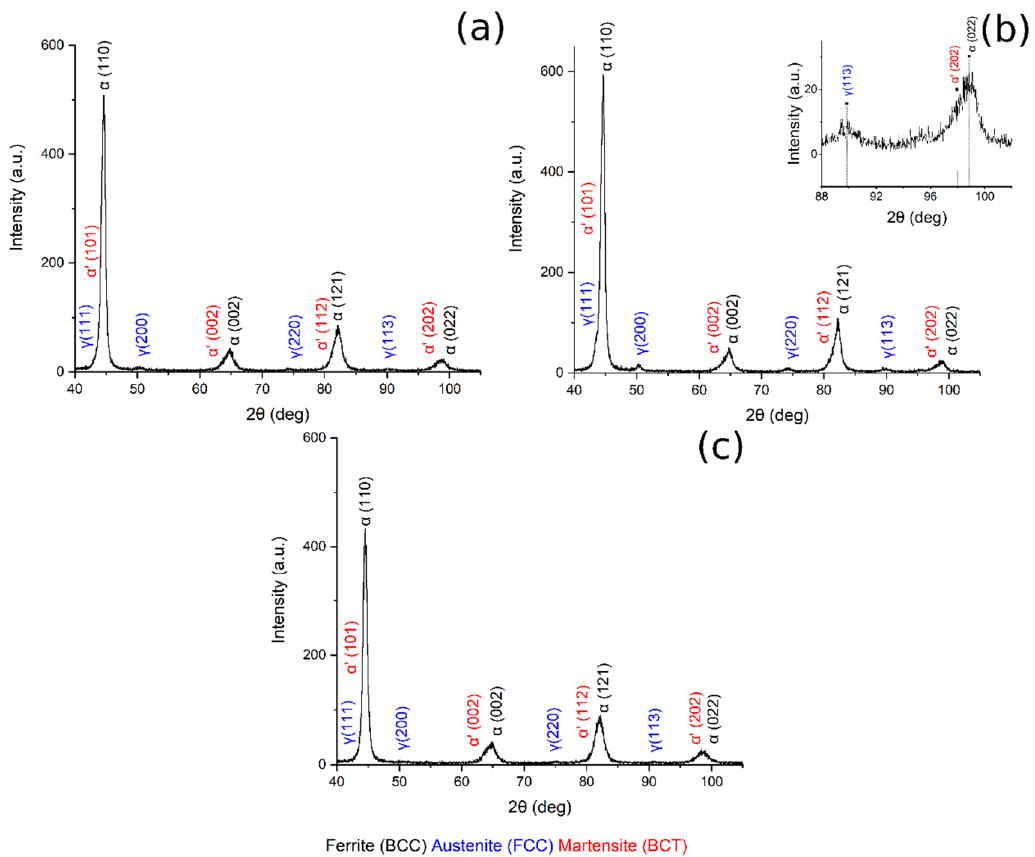
Figure 8. XRD pattern ( a ) 900 °C + 300 °C, ( b ) 900 °C + 350 °C, in the box upon on the right can be found a zoom of the pattern in the range 88–102°, ( c ) 900 °C + 400 °C.